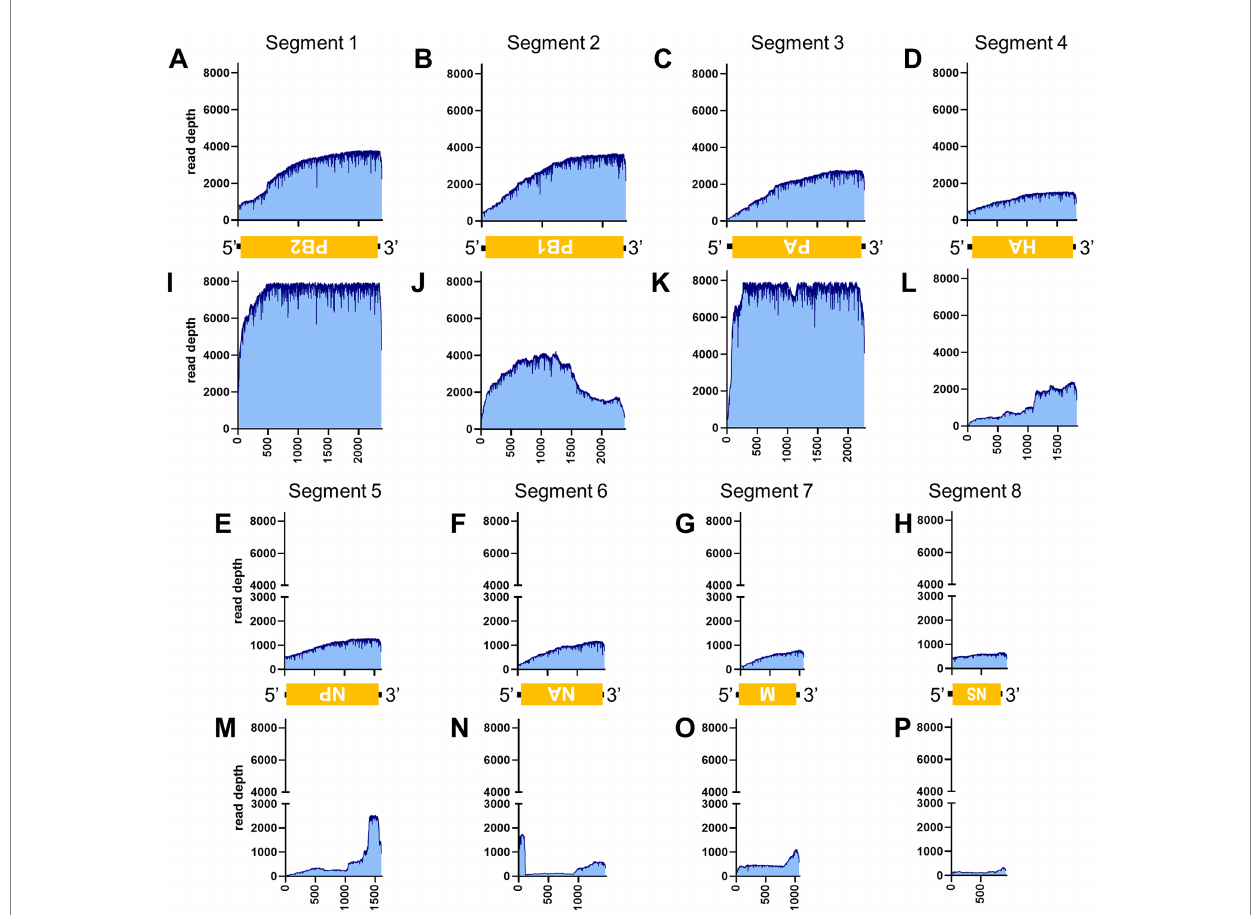
FIGURE 6 Read depth aligned to IAV reference genome. Read depth across the segments 1 (A,I) , 2 (B,J) , 3 (C,K) , 4 (D,L) , 5 (E,M) , 6 (F,N) , 7 (G,O) and 8 (H,P) segments using data generated from PCR-NGS method [upper panels: (A–H) ] or RCA-NGS method [lower panels: (I–P) ] are shown. The schematic view of the open reading frames (ORFs) and UTRs are shown as yellow boxes and black lines in the 5 ′ -to-3 ′ direction. The product of ORF is shown in the box, and the turned letter indicates the ORF is in the reverse complement (i.e., 3 ′ -to-5 ′ direction). The number of reads (y-axis) obtained at each nucleotide base pair position (x-axis) is